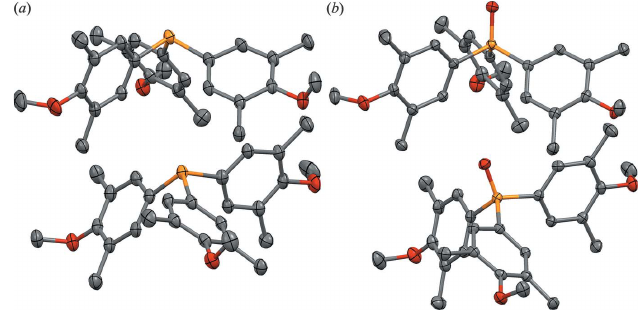
Figure 4 Views with the b axes vertical in the page, showing the staggered pyramids of ( a ) phosphine (III) and ( b ) phosphine oxide (IV) molecules in their respective crystal structures. [Symmetry code for upper (cid:5) x , (cid:5) 1 molecules: (ii) 3 + y , z 2 2